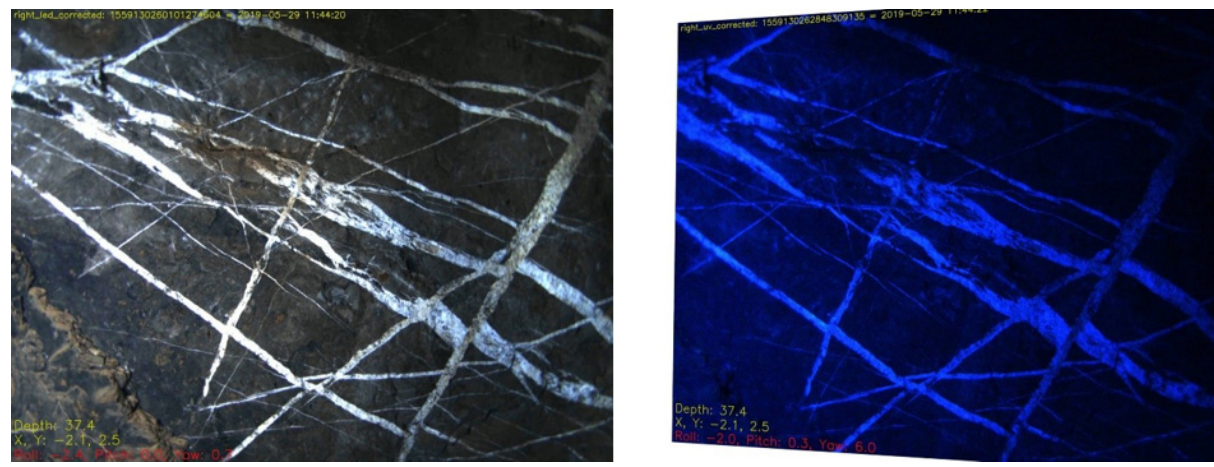
Figure 5. UV fluorescence camera enhancing the multiple generations of calcite veining – Ecton Mine, UK (figures from UNEXMIN GeoRobotics Ltd.).